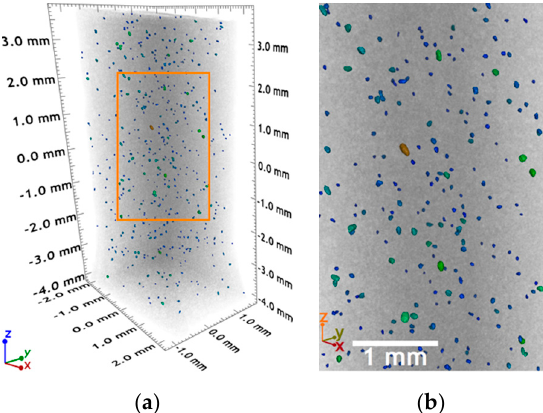
Figure 3. ( a ) 3D rendering of the CuNi NW-loaded resin and ( b ) magnification of the region in the red rectangle in ( a ).